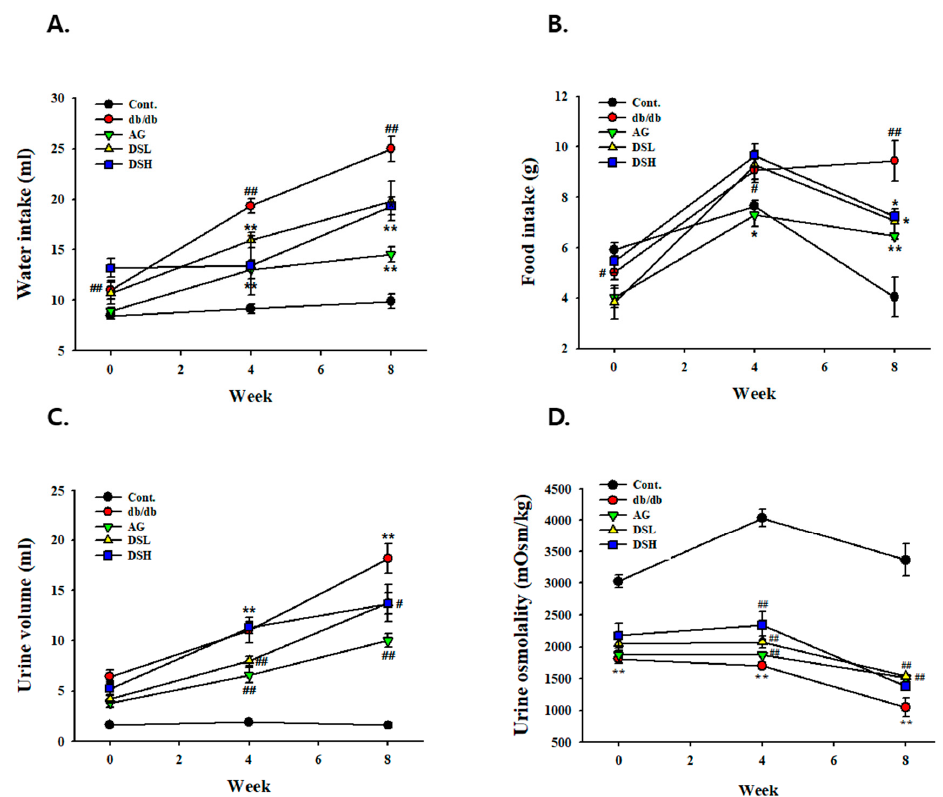
Figure 2. Effects of DS-EA on water intake, food intake ( A ), urine volume ( B ), urine volume ( C ), and urine osmolality ( D ). Values are expressed as mean ± S.E. ( n = 8). ** p < 0.01 vs. Cont.; # p < 0.05, ## p < 0.01 vs. negative Cont.; Cont.: db/m mice group; db/db: db/db mice group (negative Cont.); AG: db/db mice treated with aminoguanidine group; DSL: db/db mice treated with low-dose DS-EA group; DSH: db/db mice treated with high-dose DS-EA group; S.E., standard